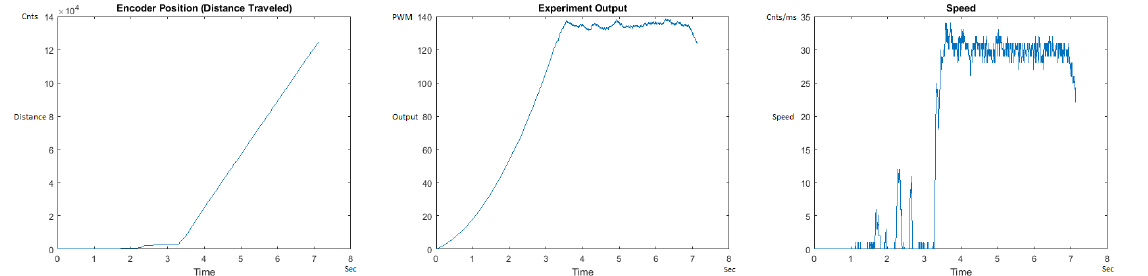
Figure 20. Encoder position, output and speed plots for PID++ UP operation— Vmax 30 cnts/ms, Adesired 0.040 cnts/ms 2 — 1 Kg.